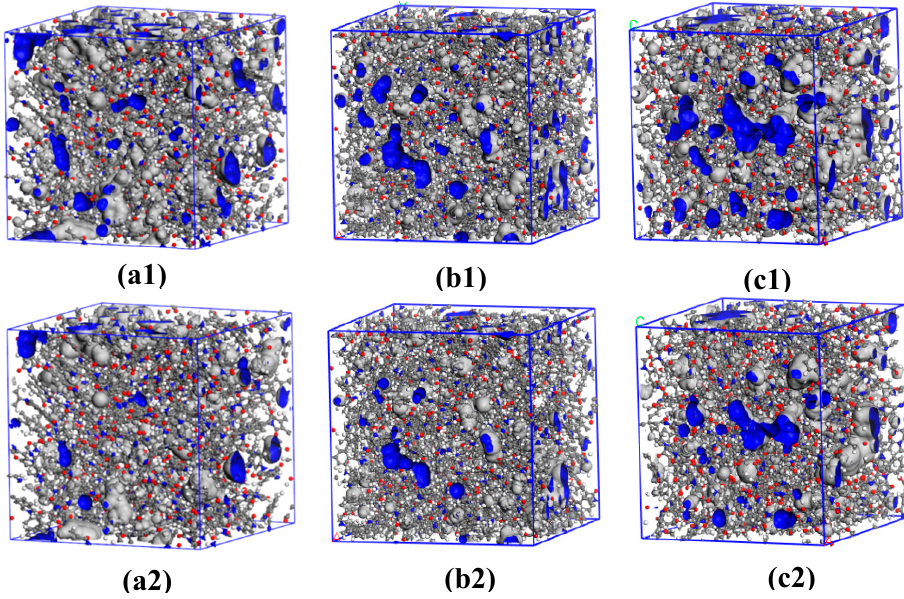
Figure 9. Three-dimensional representation of H 2 O and O 2 accessible volume for ( a1 ) ( a2 ) 2,7-CPI, ( b1 ) ( b2 ) 2,7-CPPI and ( c1 ) ( c2 ) Kapton. (grey: Van der Waals surface; blue: Connolly surface; a1, b1 and c1: probe radius of 1.325 Å; a2, b2 and c2: probe radius of 1.73 Å).